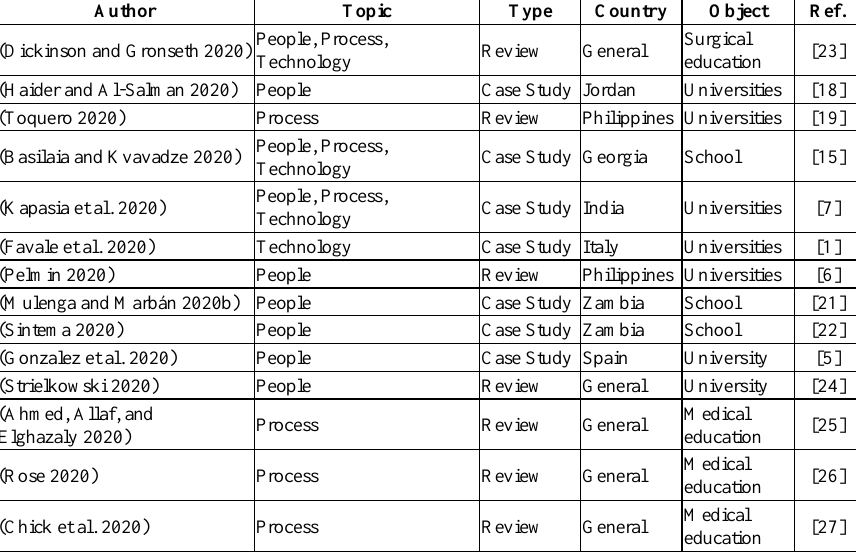
Table 1. Final data of relevant literature for this research